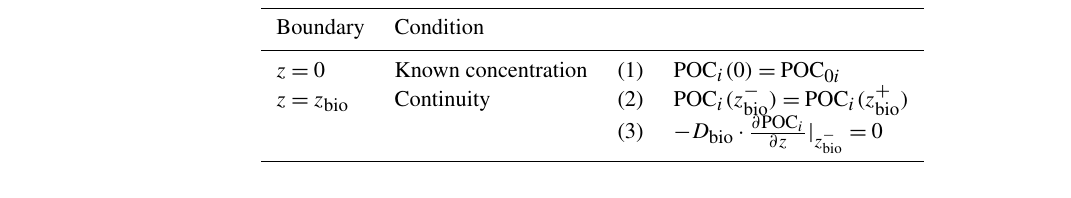
= lim h → − h) and z + = lim h → + 0 (z bio 0 (z bio bio bio